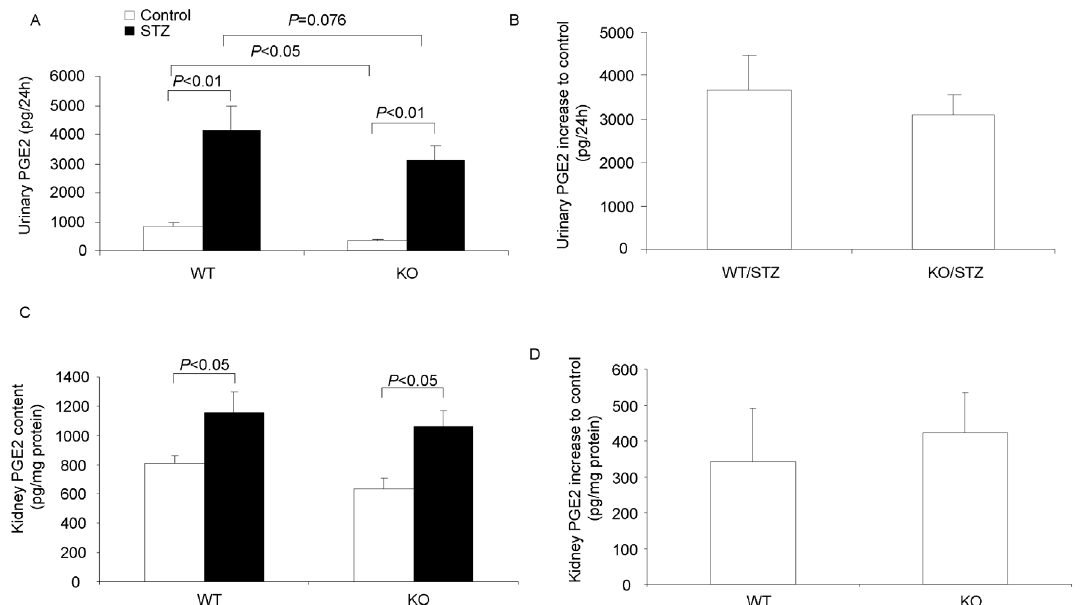
Figure 3. Urinary PGE2 excretion and renal PGE2 content in diabetic mice. (A) 24-hour urinary PGE2 excretion after 6 weeks of diabetes. (B) Increase of 24-hour urinary PGE2 excretion after 6 weeks of diabetes. (C) Kidney PGE2 content after 6 weeks of diabetes. (D) Increase of kidney PGE2 content after 6 weeks of diabetes. N=6–9 in each group. Data are mean 6 SE.